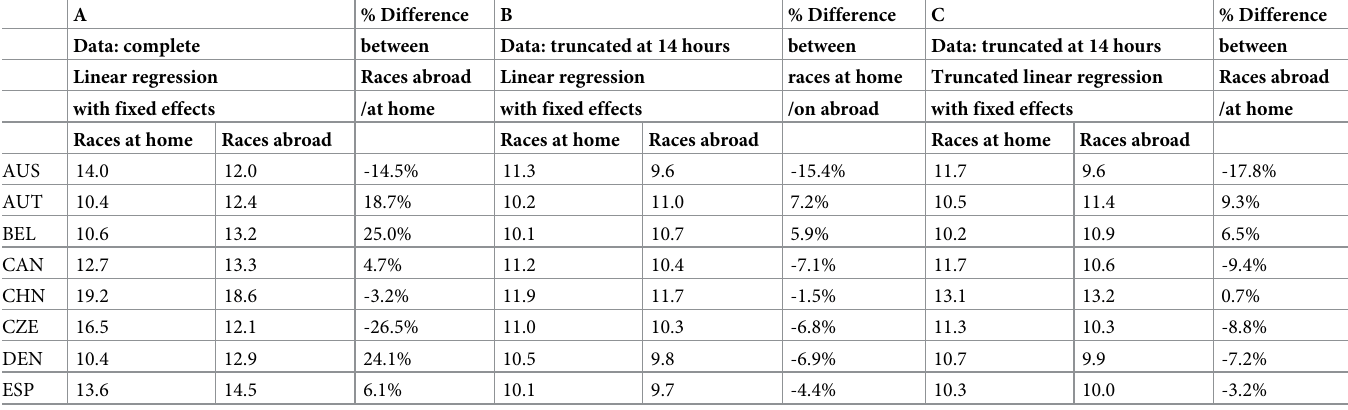
Table 16. Comparing times in hours with finishes performed at home. Times were computed based on the model time = sex × (year+year 2 ) +sex × (age+age 2 ) + sex × na- tionality × site and referenced to male, age 44, year 2009 and nationality